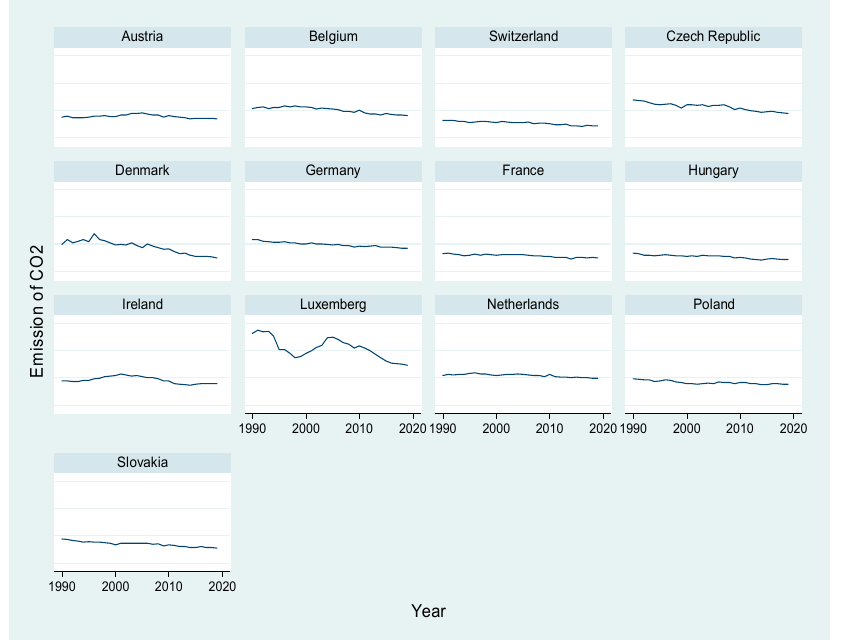
Figure 3. The trend of CO 2 emission in the selected country during 1990 to 2019.